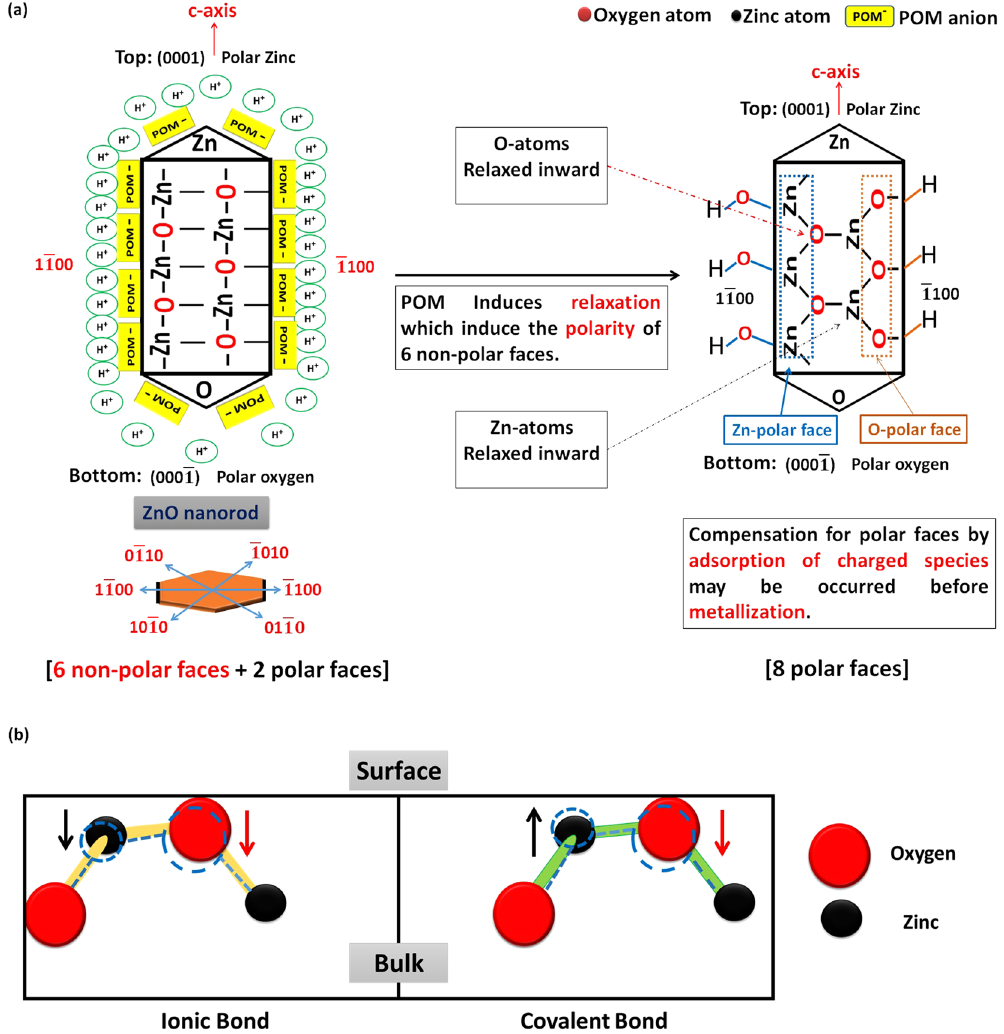
Figure 12. Schematic illustration for the effect of (POM) anions adsorbed on ZnO surface on surface relaxation and polarity ( a ), and the expected relaxation modes [doted lines indicate the position of atoms after relaxation process] ( b